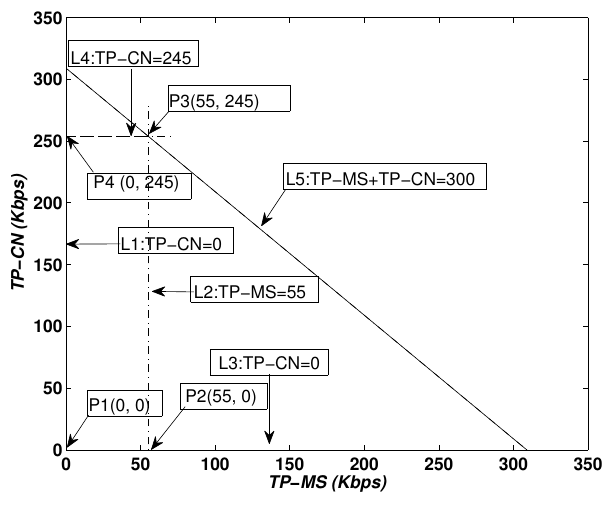
Figure 7. Throughput: feasible